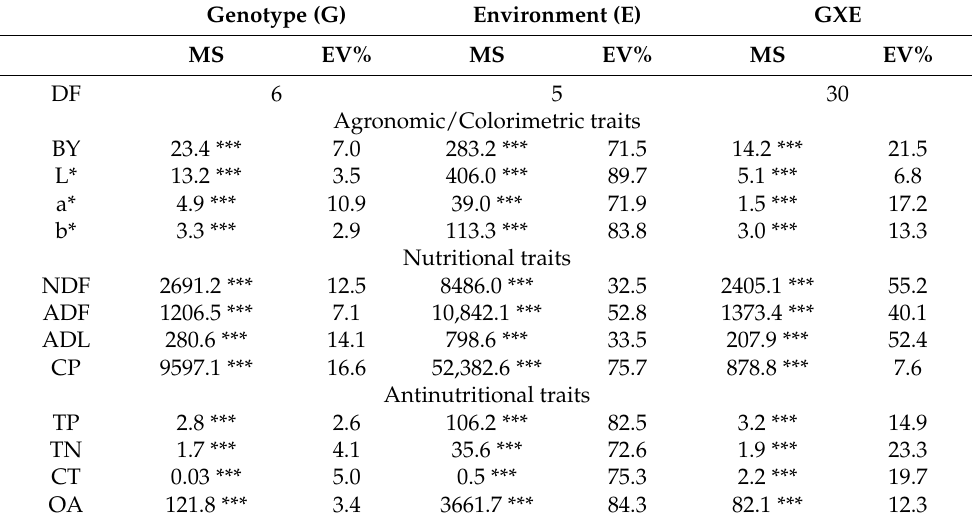
Table 3. Mean squares (MS) and percentage of the sum of the squares (EV%) for biomass/colorimetric, nutritional, and antinutritional traits of V. sativa biomass produced by seven genotypes across six